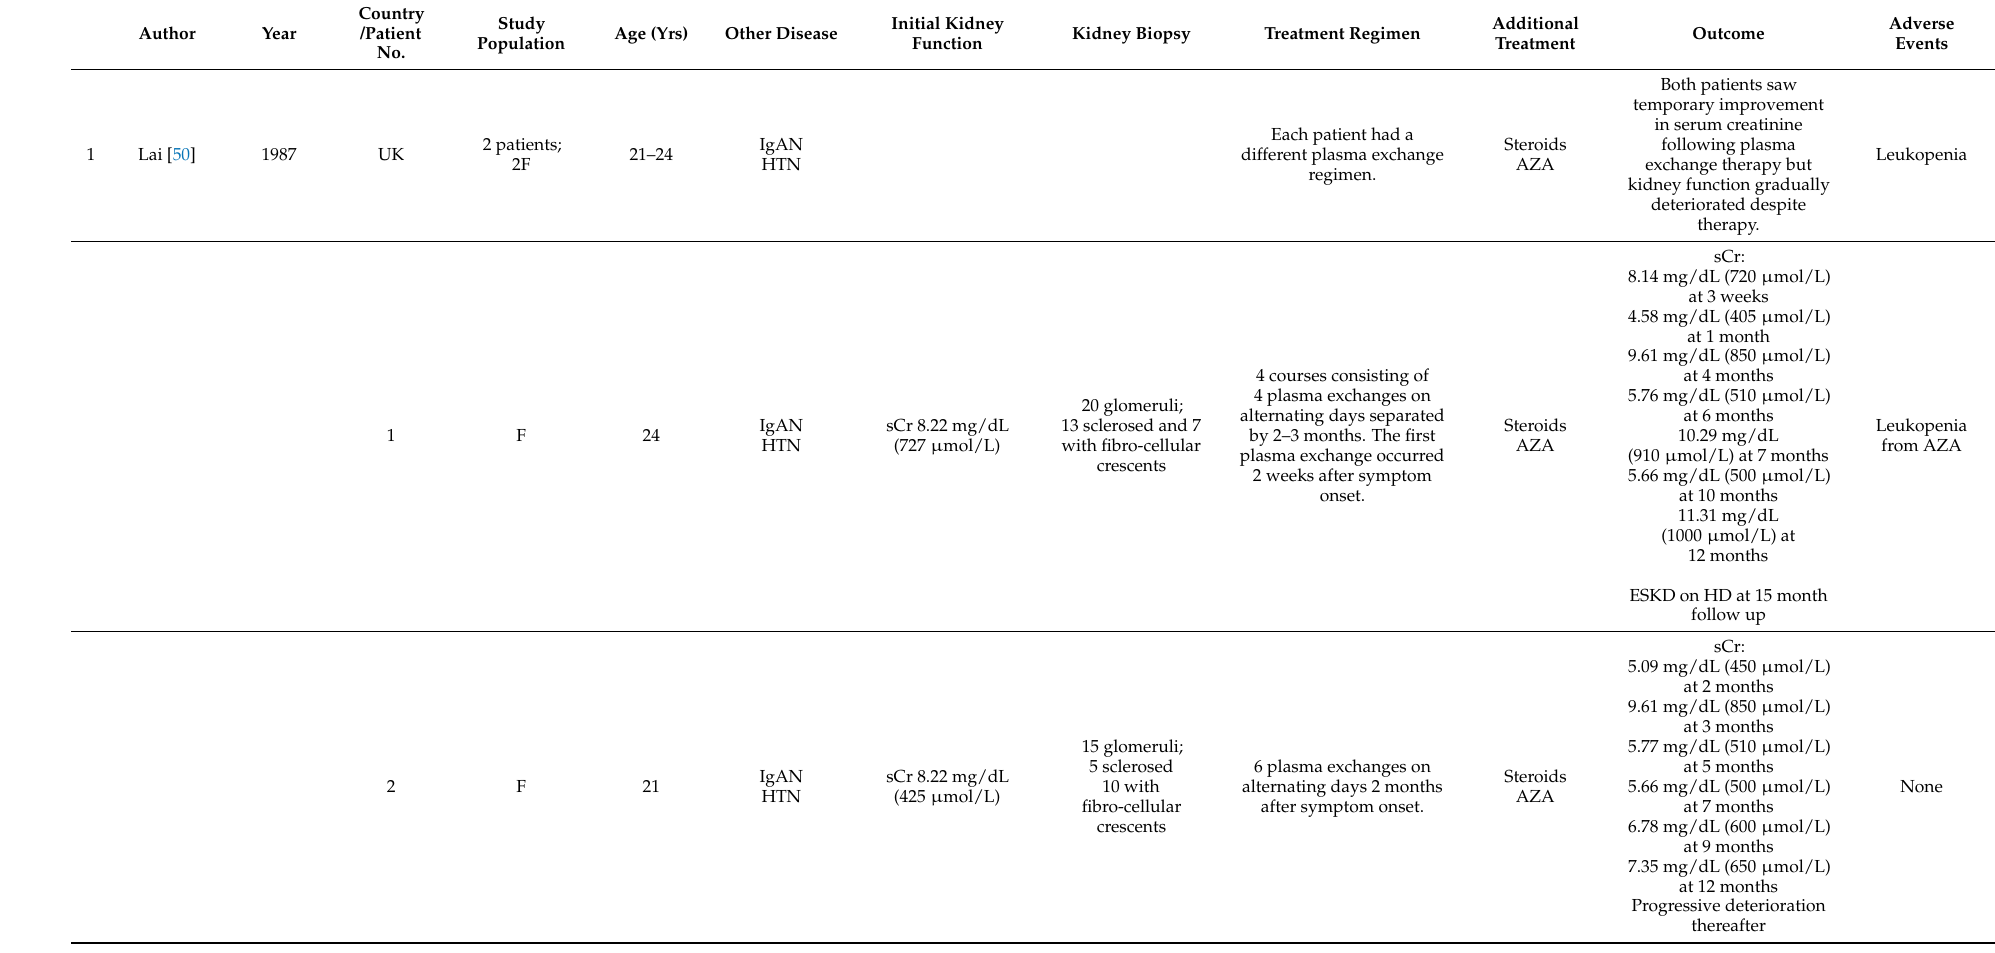
Table 2. Characteristic of included case